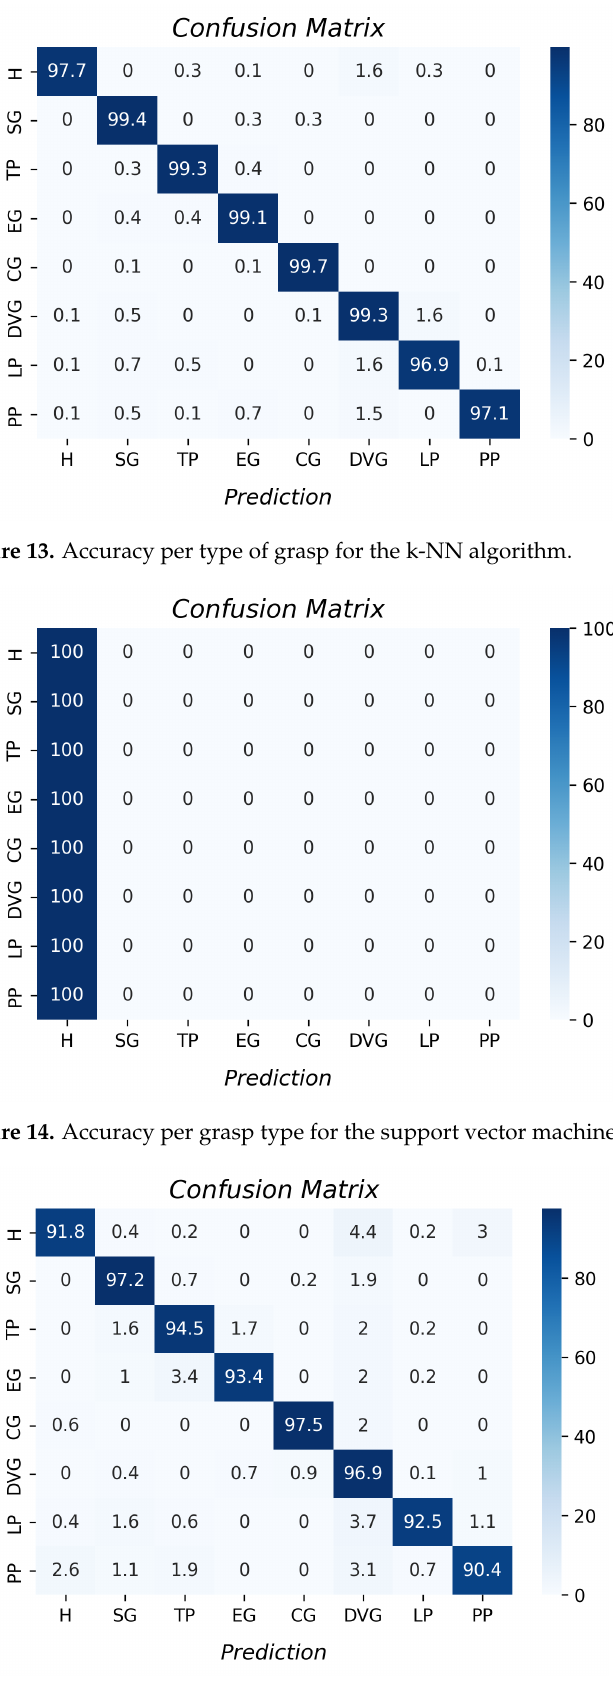
Figure 15. Accuracy per type of grasp for the decision tree